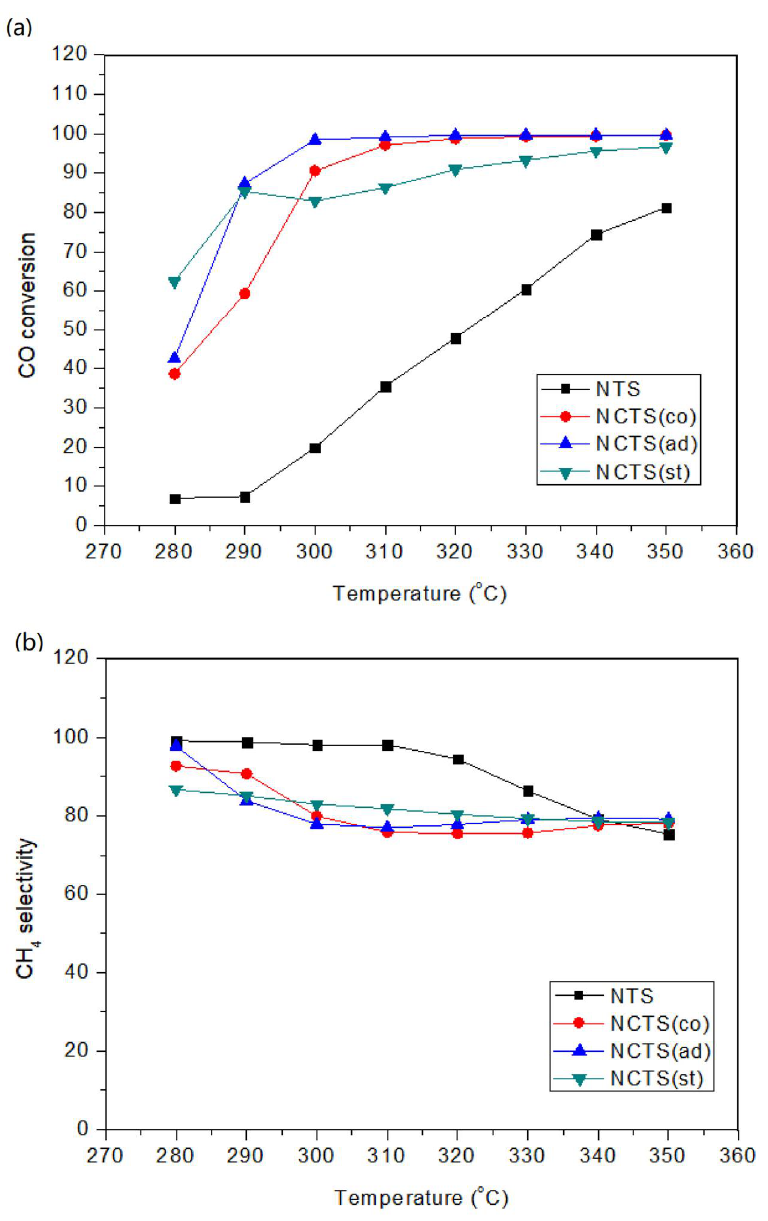
Figure 1. Effect of reaction temperature on the ( a ) activities of catalysts (CO conversion) and ( b ) CH 4 selectivity and reaction condition: H 2 /CO = 3, GHSV = 7500 h −1 , atmospheric pressure. Table 1. Rate of CH 4 generation.